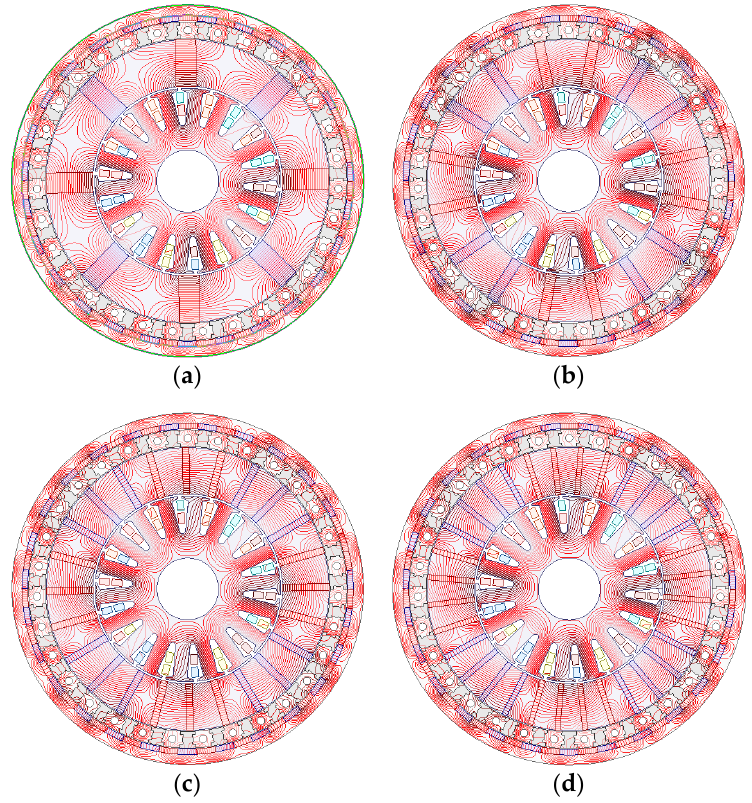
Figure 7. Flux lines of four spoke-type structures with no load: ( a ) one segment; ( b ) two segments; ( c ) three segments; and ( d ) four segments.